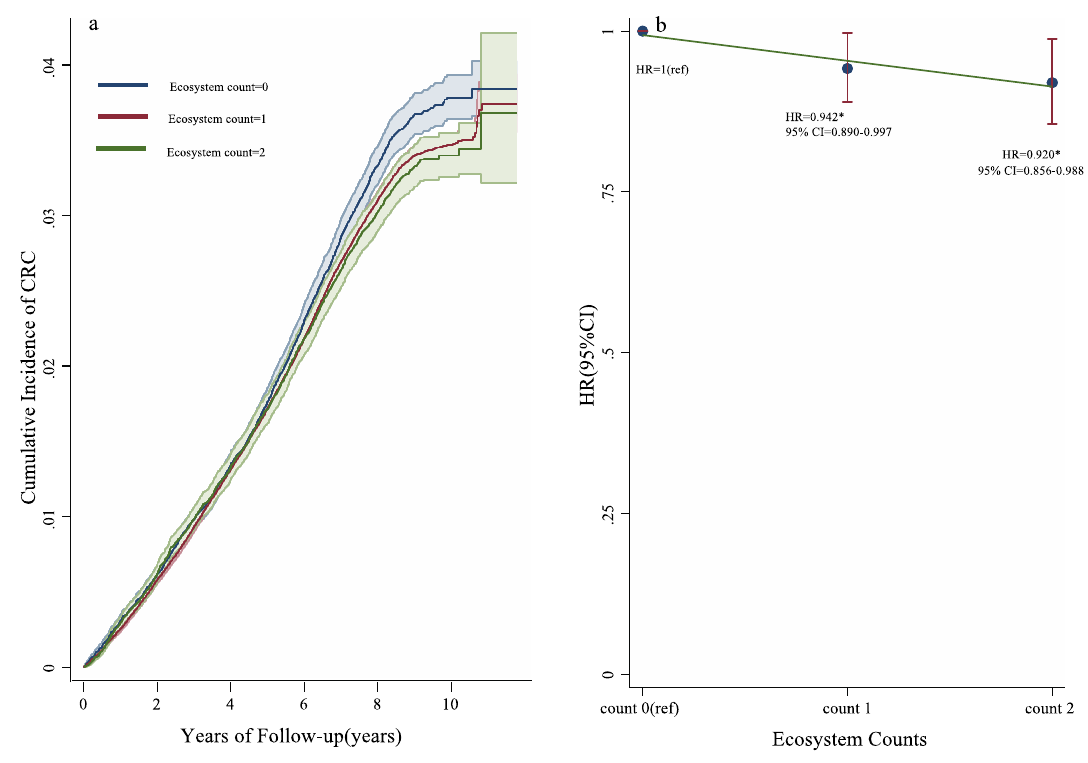
Figure 6. Effects of ecosystem counts on the risk of incident CRC in the UKB